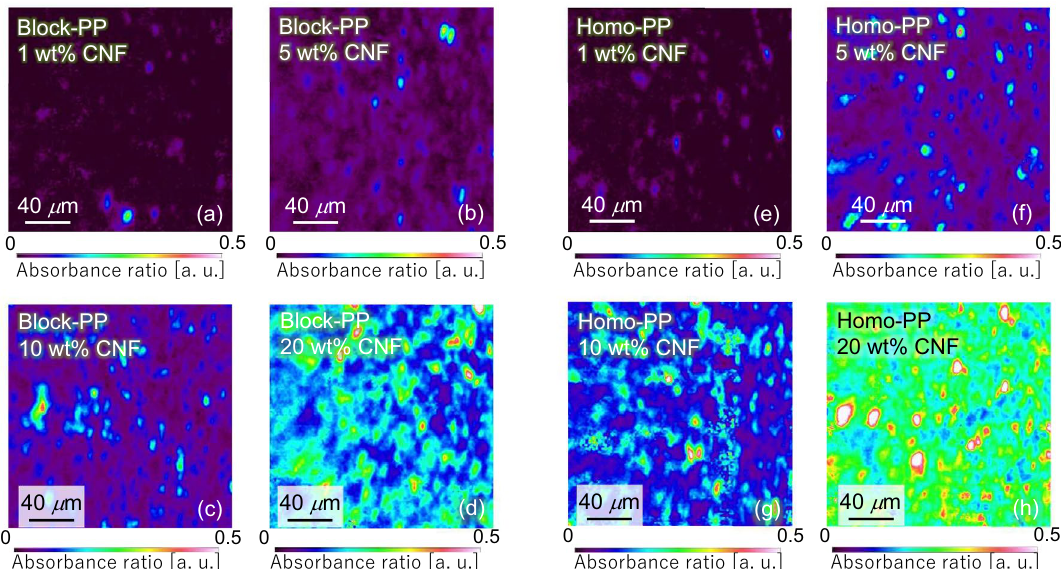
Figure 4. Two-dimensional distribution of CNF in PP calculated using the integrated absorbance ratio of CNF to PP: ( a ) Block-PP/1 wt% CNF, ( b ) block-PP/5 wt% CNF, ( c ) block-PP/10 wt% CNF, ( d ) block-PP/20 wt%